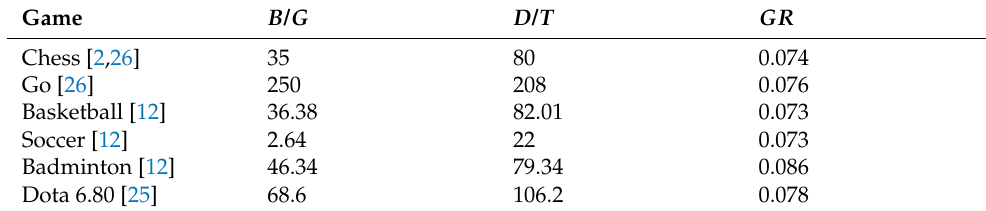
Table 1. GR measure of several sophisticated games